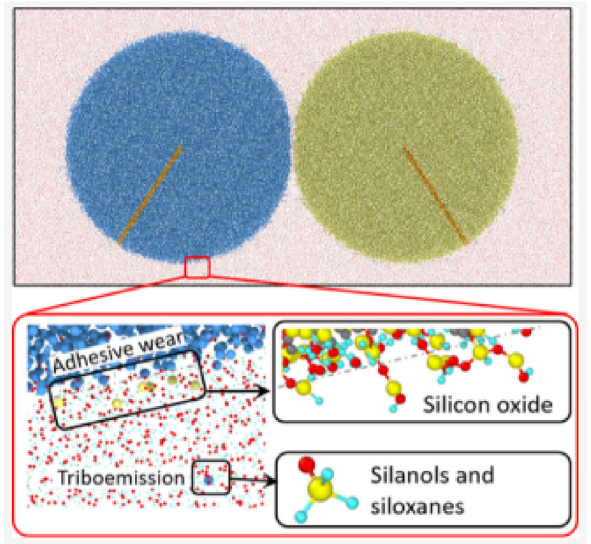
Fig. 78 Snapshots from the rolling friction simulation of SiC in a water environment [938]. Reproduced with permission from Ref. [938], © American Chemical Society,